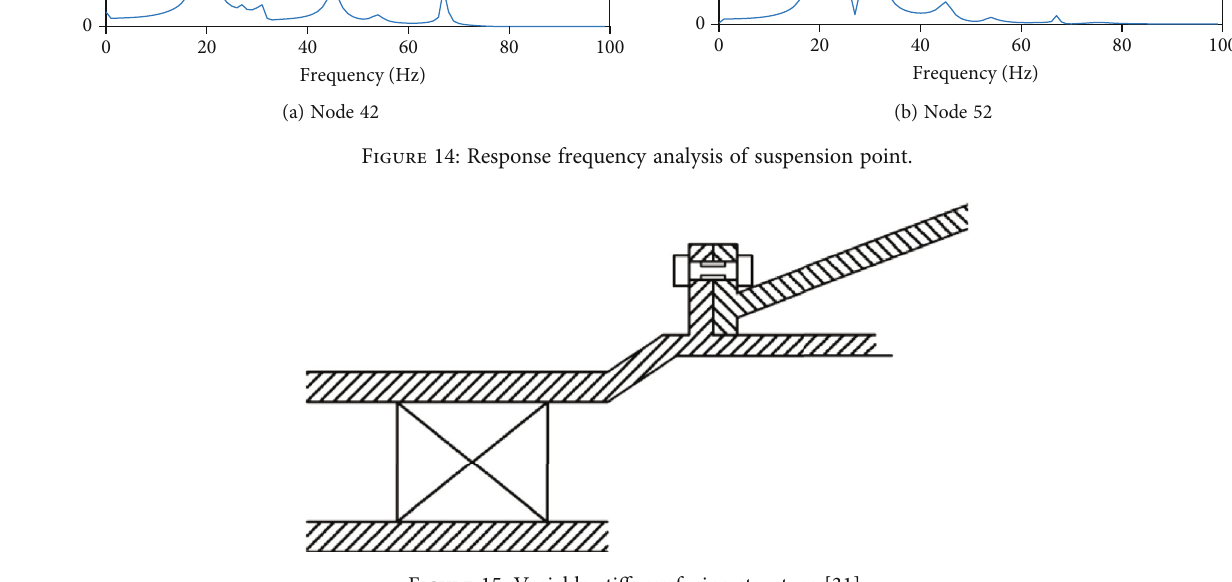
Figure 15: Variable-sti ff ness fusing structure [31].